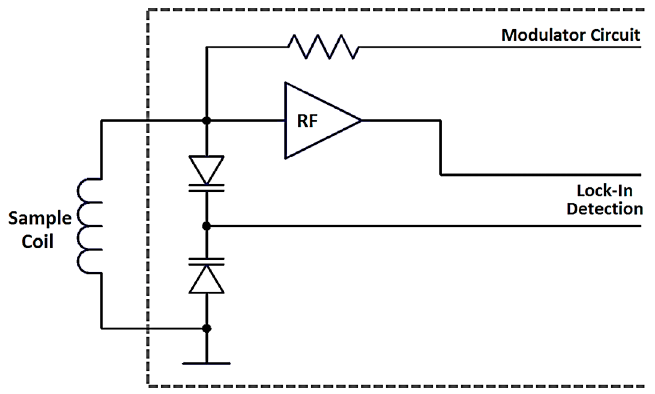
Figure 14. Front end of Weyand’s low field magnetometer, utilizing varicap diode tuning.